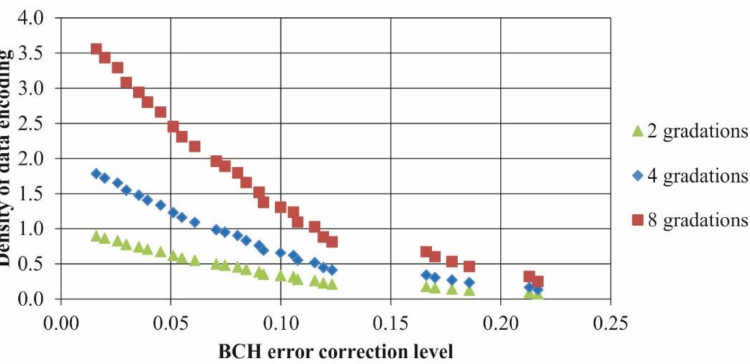
Figure 6. Dependencies of the density of data encoding on BCH error correction level for MCDDC with different number of gray levels (color online).